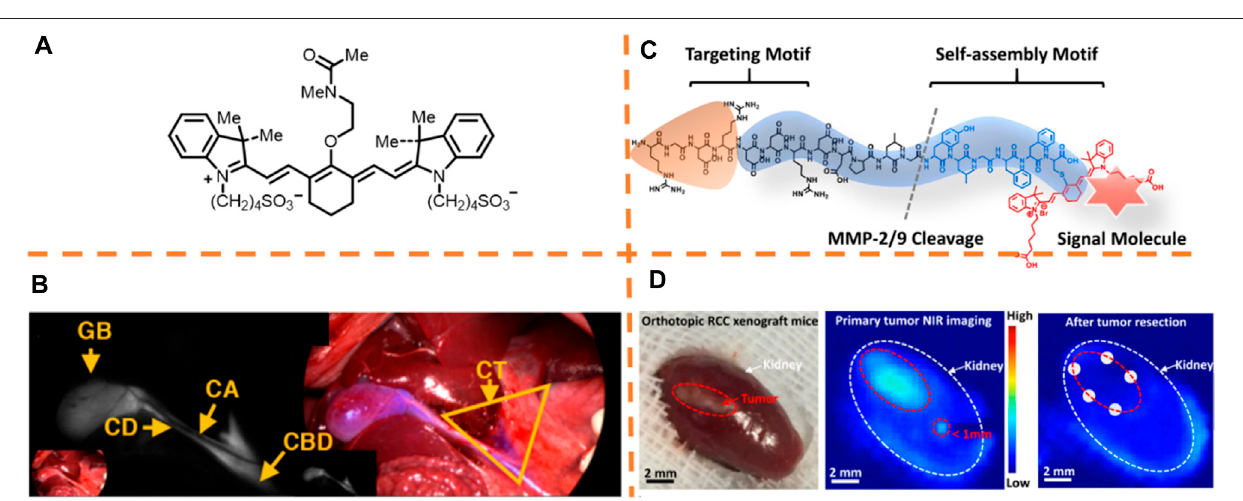
FIGURE 1 | (A) Chemical structures of the fl uorescent dye BL (bile label)-760. (B) Dissection on the liver hilum (left) and liver resection surgery (right). Adapted with permissionfrom Lucianoet al.(2019). (C) Schematicillustrationofthemoleculardesign. (D) Typicalmacroscopic fi gures oftheorthotopic786-Oxenograftmice sample (left). Related NIR fl uorescence fi gures oftheorthotopic 786-O xenograft mice sampleafter intravenouslygoverningtheTERmeasure (middle).Arbitrarybiopsy ( n (cid:1) 5)at the margin (right). Adapted with permissions from An et al. (2020).